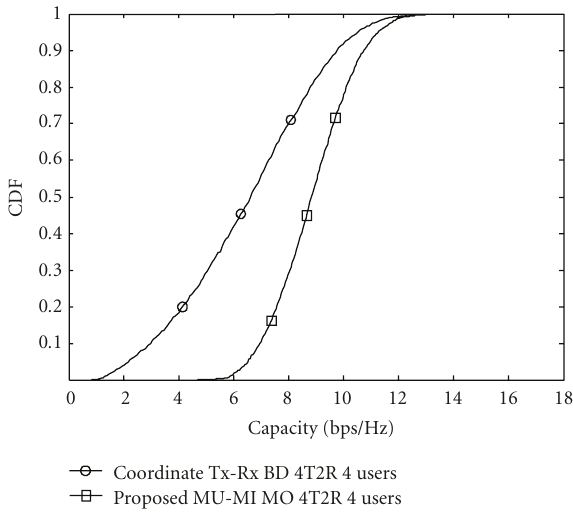
Figure 4: The system capacity CDF comparison of the two